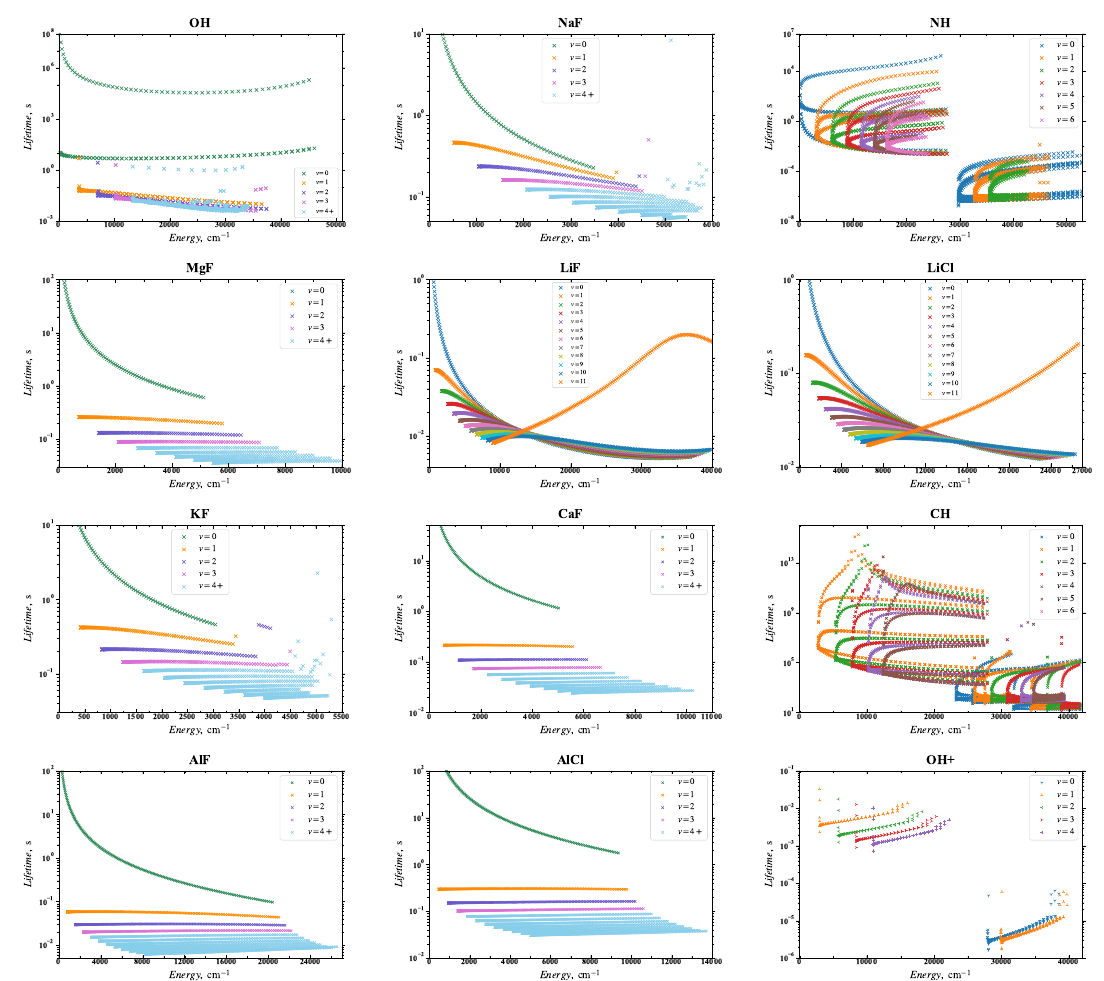
Figure 11. Lifetimes as a function of state energy for the line lists considered in this article. The plots give results for the main isotopologue